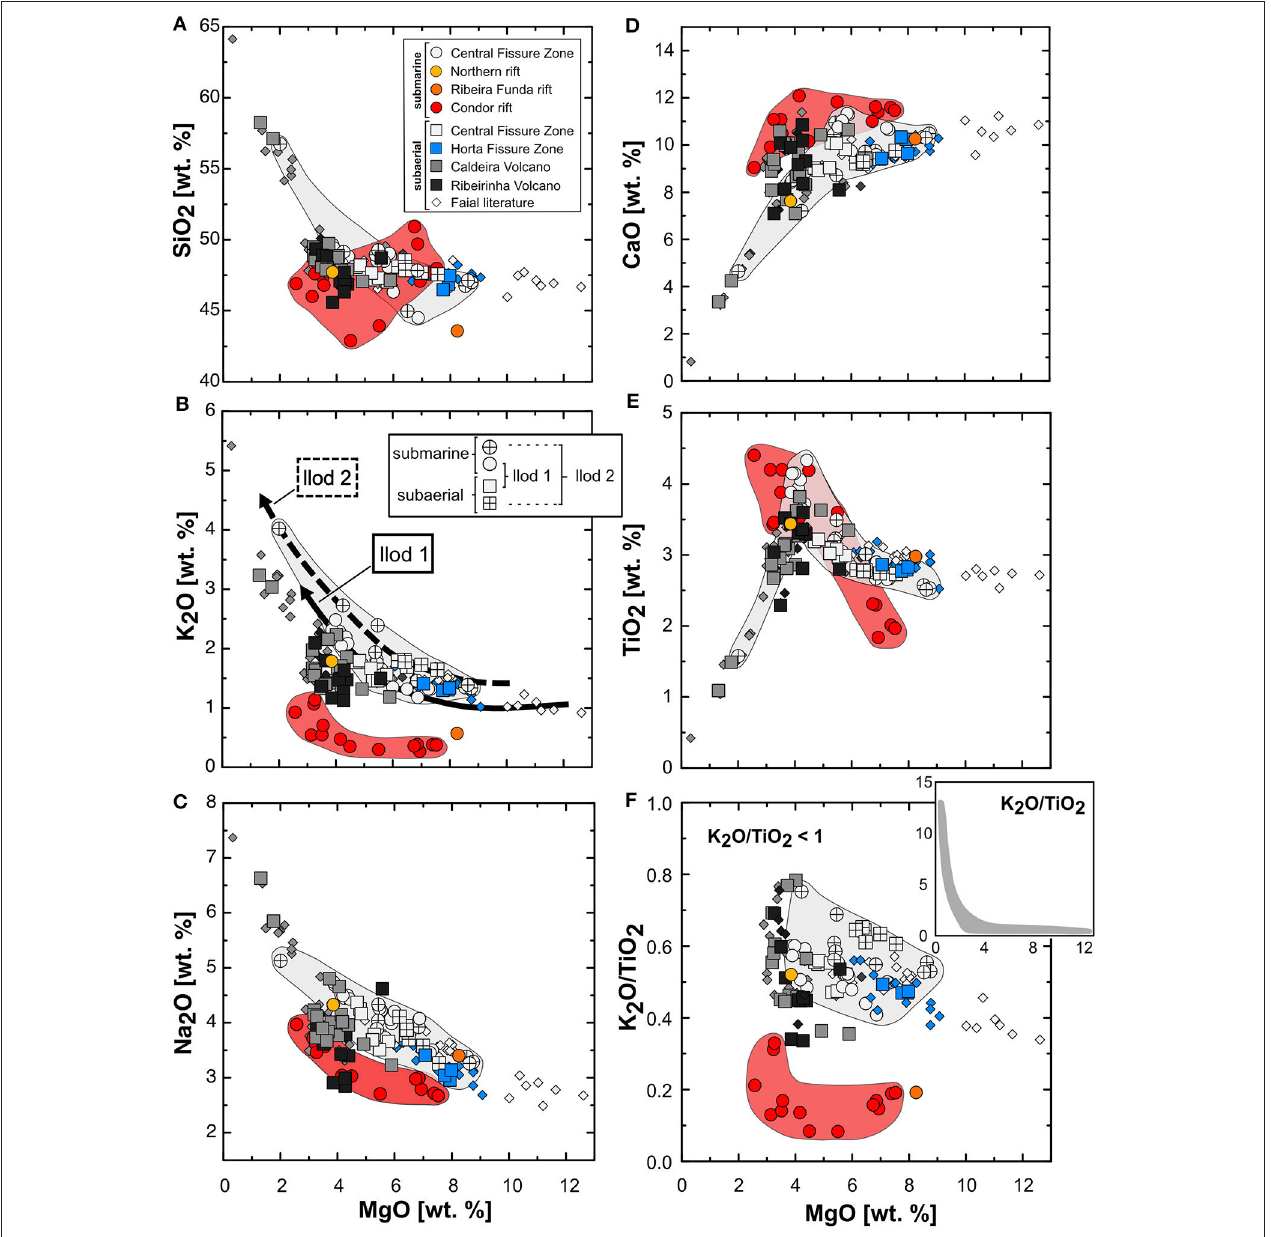
FIGURE 4 | (A-E) Major element contents and (F) K 2 O/TiO 2 ratios vs. MgO [wt. %]. Symbols are the same as in Figure 2 . Red and white areas highlight our samples from Condor rift and the Central Fissure Zone, respectively. Two liquid lines of descent with lower (llod 1) and higher (llod 2) K 2 O contents are distinguished [ (B) , see also Figure 6 ]. Arrows in (B) schematically highlight llod1 (solid line) and llod2 (dashed line). Diamonds are subaerial samples from Zanon et al. (2013) and Hildenbrand et al. (2014). The colors are the same as used for our samples and refer to the respective volcanic units distinguished in Figure 2 . Inset in (F) highlights the range in K 2 O/TiO 2 for all Faial lavas. Note that published samples largely overlap those from this